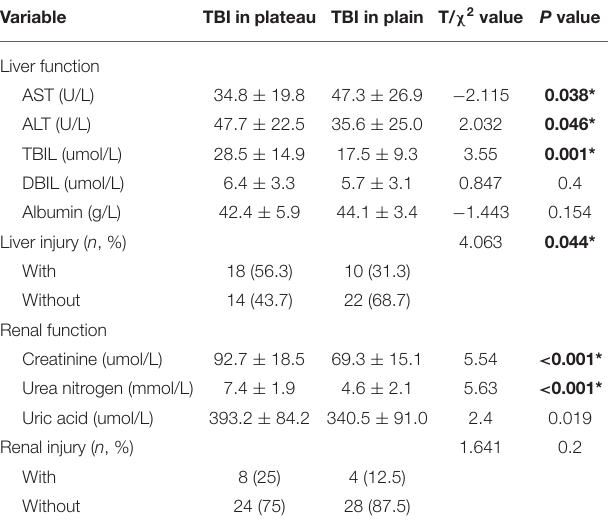
TABLE 7 | Liver and renal function of patients with TBI in plateau and plain areas. Variable